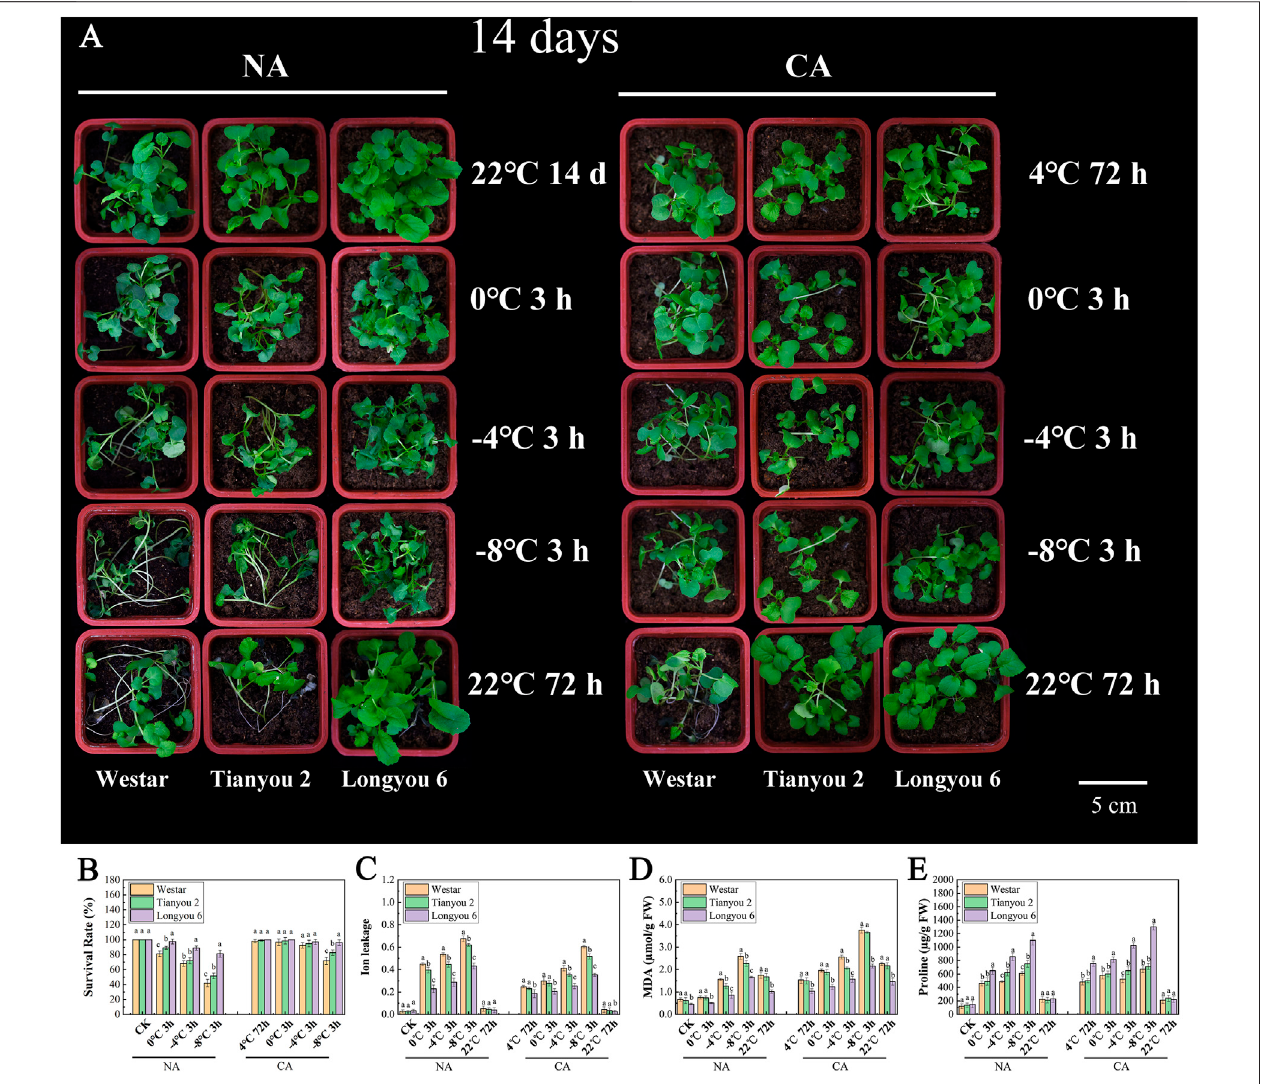
FIGURE 1 | The morphological and physiochemical characterization of B. rapa under different freezing treatments. (A) The morphological characterization of B. rapa under different freezing treatments. (B – E) The physiochemical indicators of B. rapa under different freezing treatments. Non-acclimated (NA) freezing treatment seedlings (A) left, Cold-acclimated(CA) freezing treatment seedlings (A) right. Datawere means ofthree independent biological replicates ( n ≥ 20for each repeat) ±SE. Lowercase letters present signi fi cant difference at p < 0.05 (one-way ANOVA).